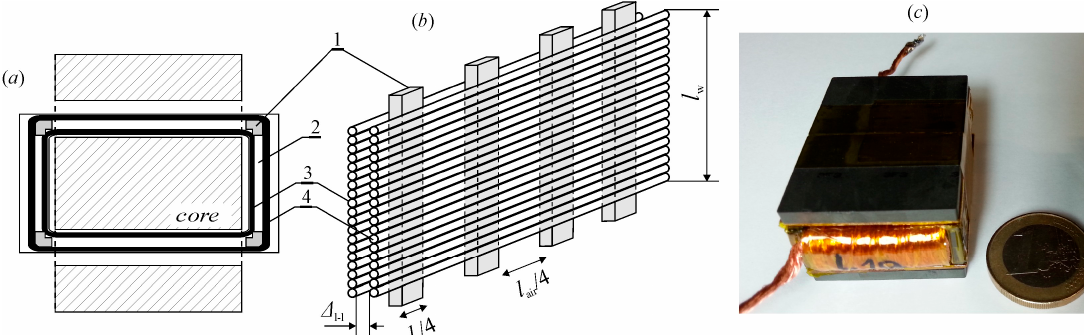
Figure 5. ( a , b ) Graphical representation of two-layer inductor constructed using the proposed method, where: 1—corners, 2—air distance between layers, 3 and 4—first and second layer and ( c ) inductor’s picture compared with 1 euro coin.